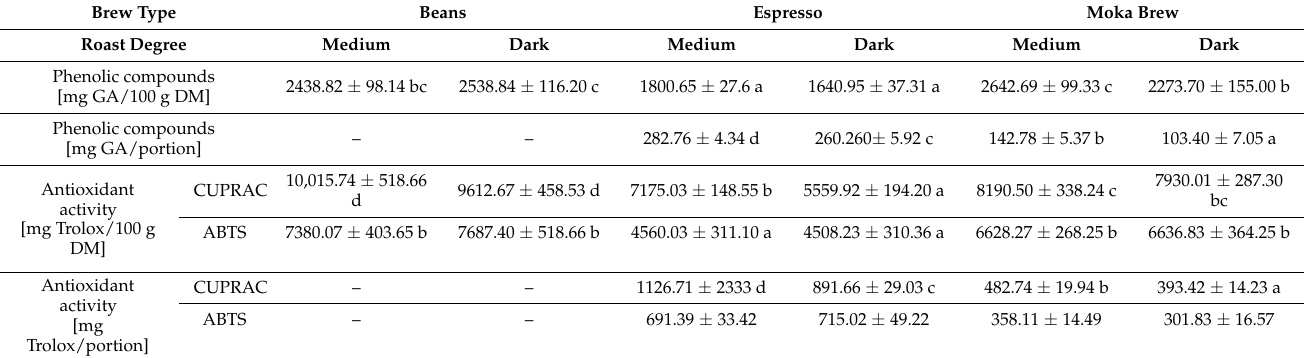
Table 3. Content of phenolic compounds and antioxidant activity measured by SET-based